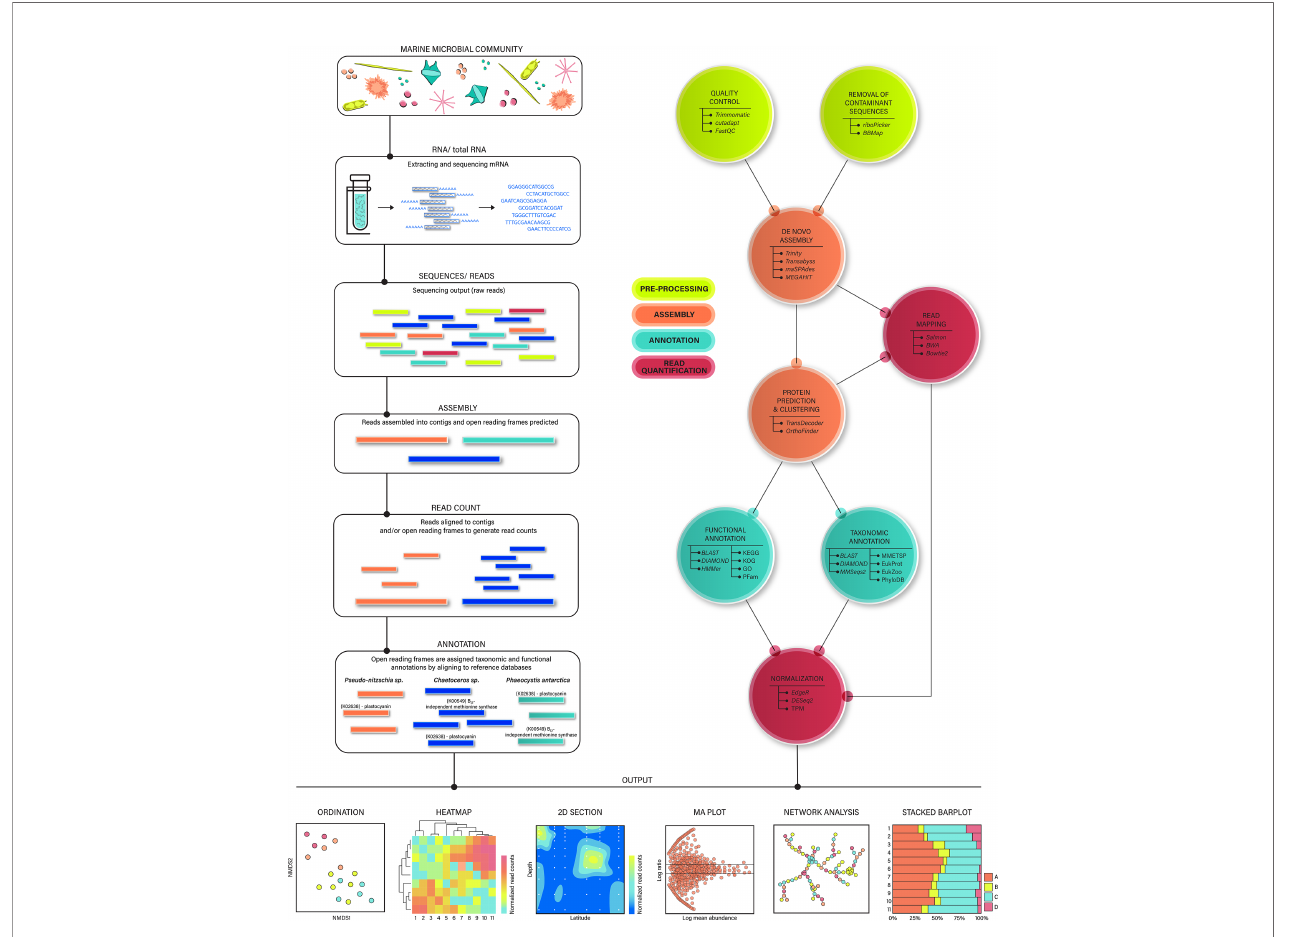
FIGURE 1 | Flow chart of a metranscriptomic pipeline designed for marine microeukaryotes (right). Visual depiction of the main work fl ow steps, including cell extraction, sequencing, assembly, read mapping, and annotations (left). Example annotations are shown for three phytoplankton taxa (Ellis et al., 2017, Cohen et al., 2017, Wu et al., 2019, Rao, 2020). Note that many predicted proteins do not correspond to a known functional annotation. Example graphics and statistical approaches used to investigate metatranscriptomic output (bottom): Ordinations may be created using orthologous groups or functional annotations aggregated to the taxonomic level of interest. Heatmaps are constructed using normalized gene expression and can be subset to include biostatistically or biologically relevant genes. Heatmaps and ordinations are useful in identifying similarities among sampling groups. 2D section plots show differences in the relative abundance of gene expression across space (or time), highlighting shifts in ecological strategies. MA plots are created using normalized gene expression corresponding to taxonomic/ functional annotations or orthologous groups, and are useful in assessing differential expression between pairwise experimental treatments or groupings. Networks are built using normalized gene expression corresponding to taxonomic/functional annotations or orthologous groups, and highlight co-occurring genes. They can be paired with metadata to identify groups of genes correlated with environmental parameters. Stacked barplots represent the relative community composition across samples, and can be produced using raw reads or normalized read counts (e.g., TPM) associated with contigs and/or predicted